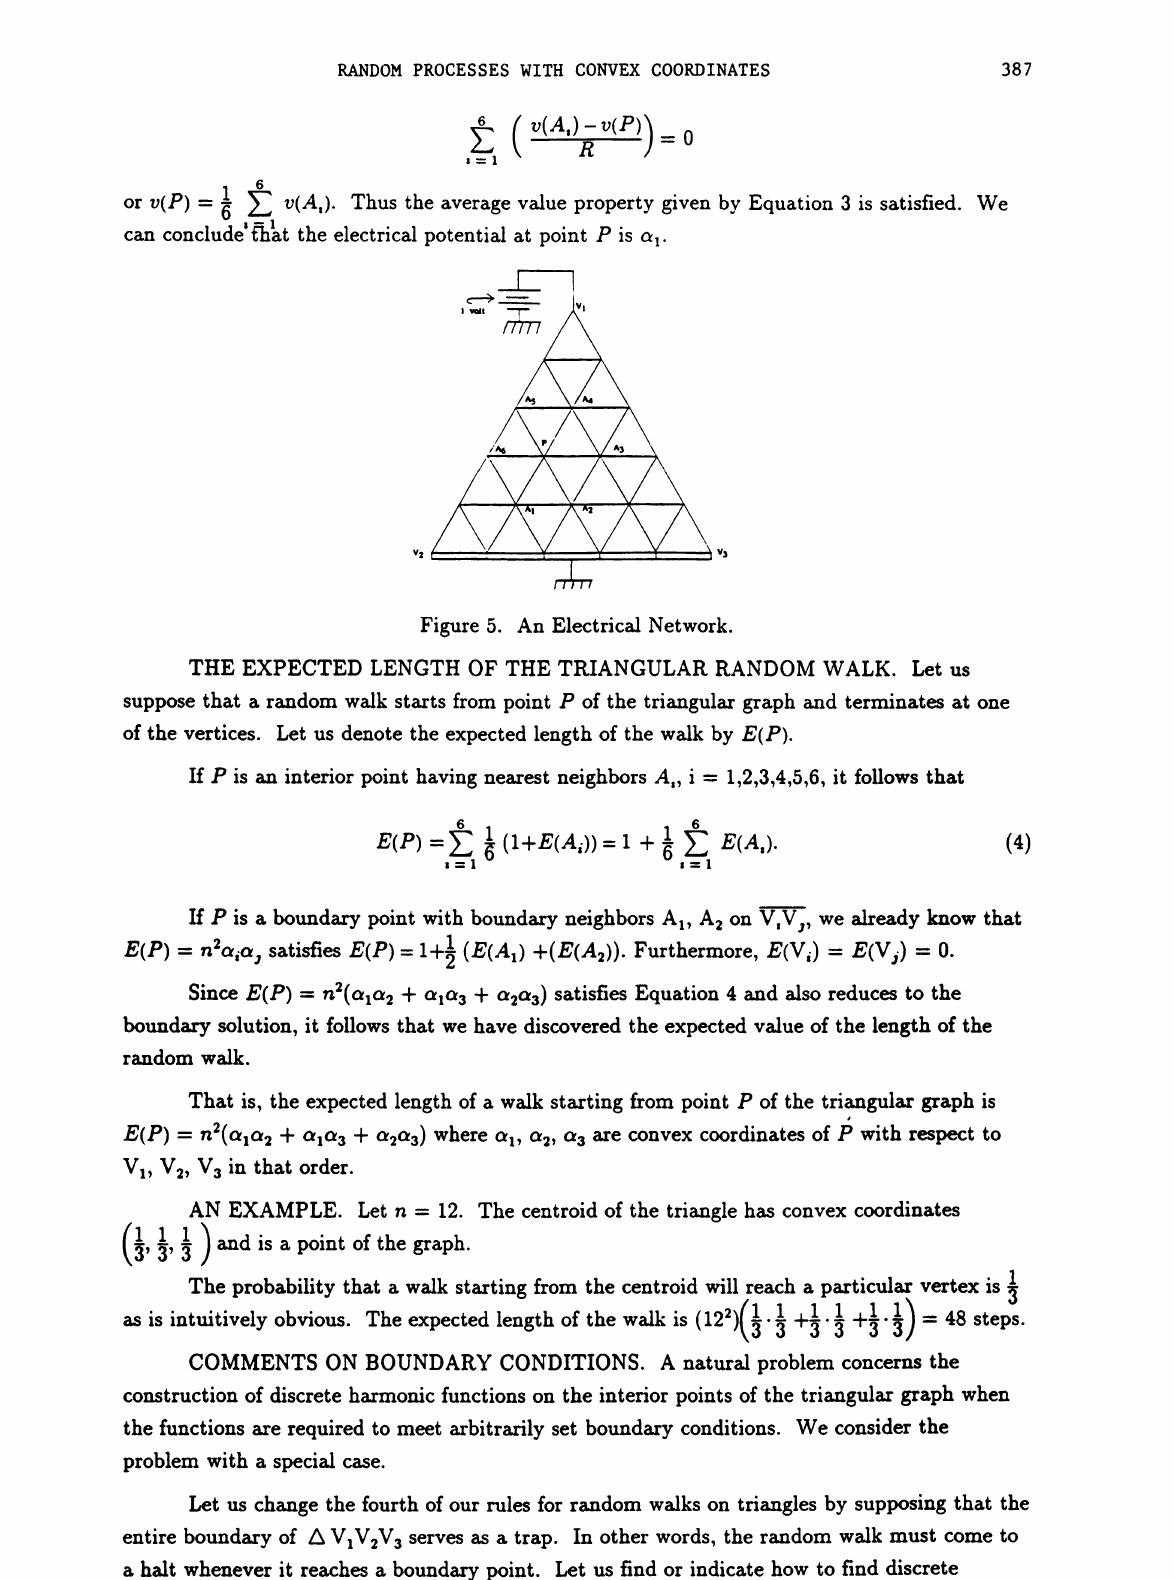
Figure 5. An Electrical